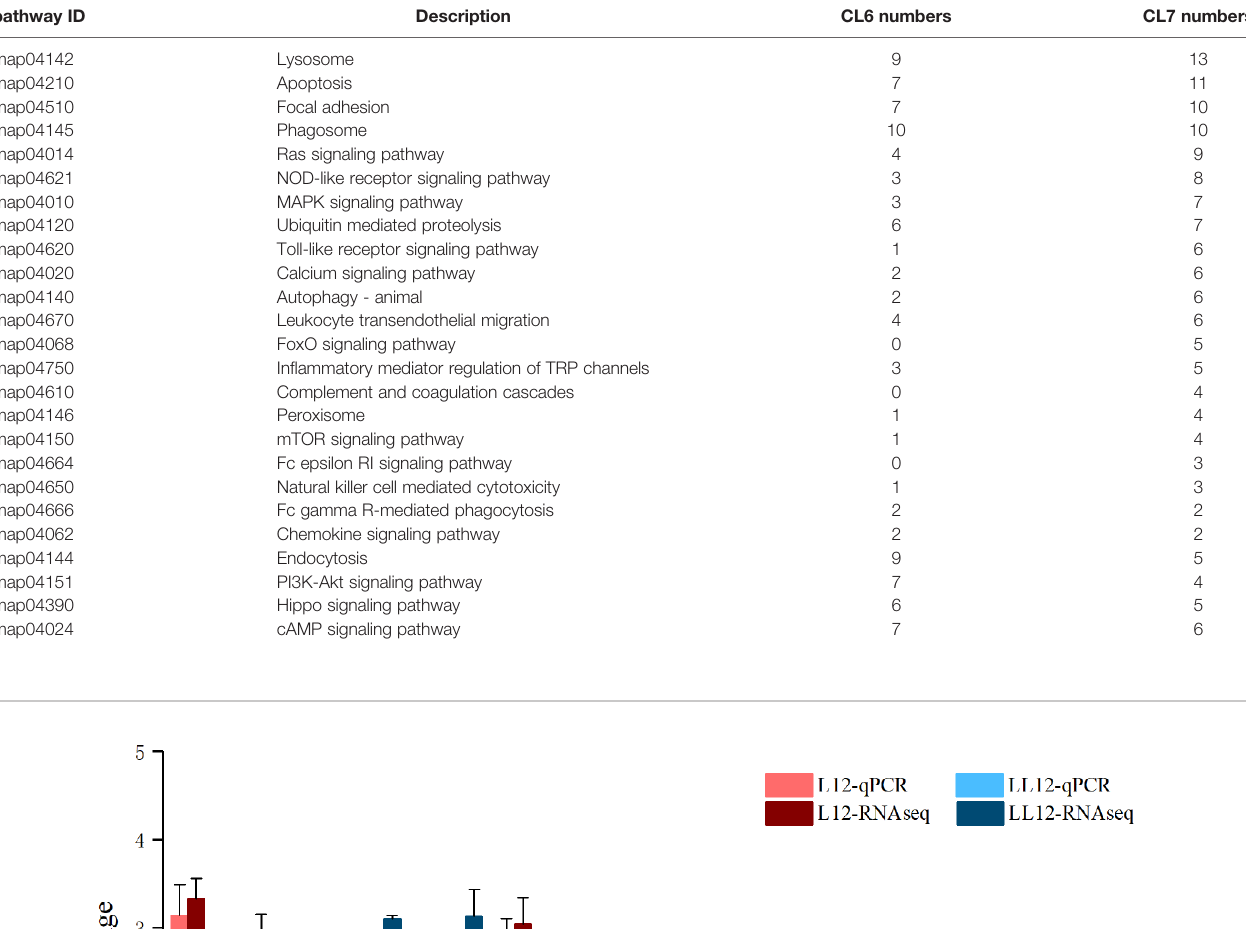
TABLE 3 | Gene numbers in the immune-related pathways in CL6 and CL7. pathway